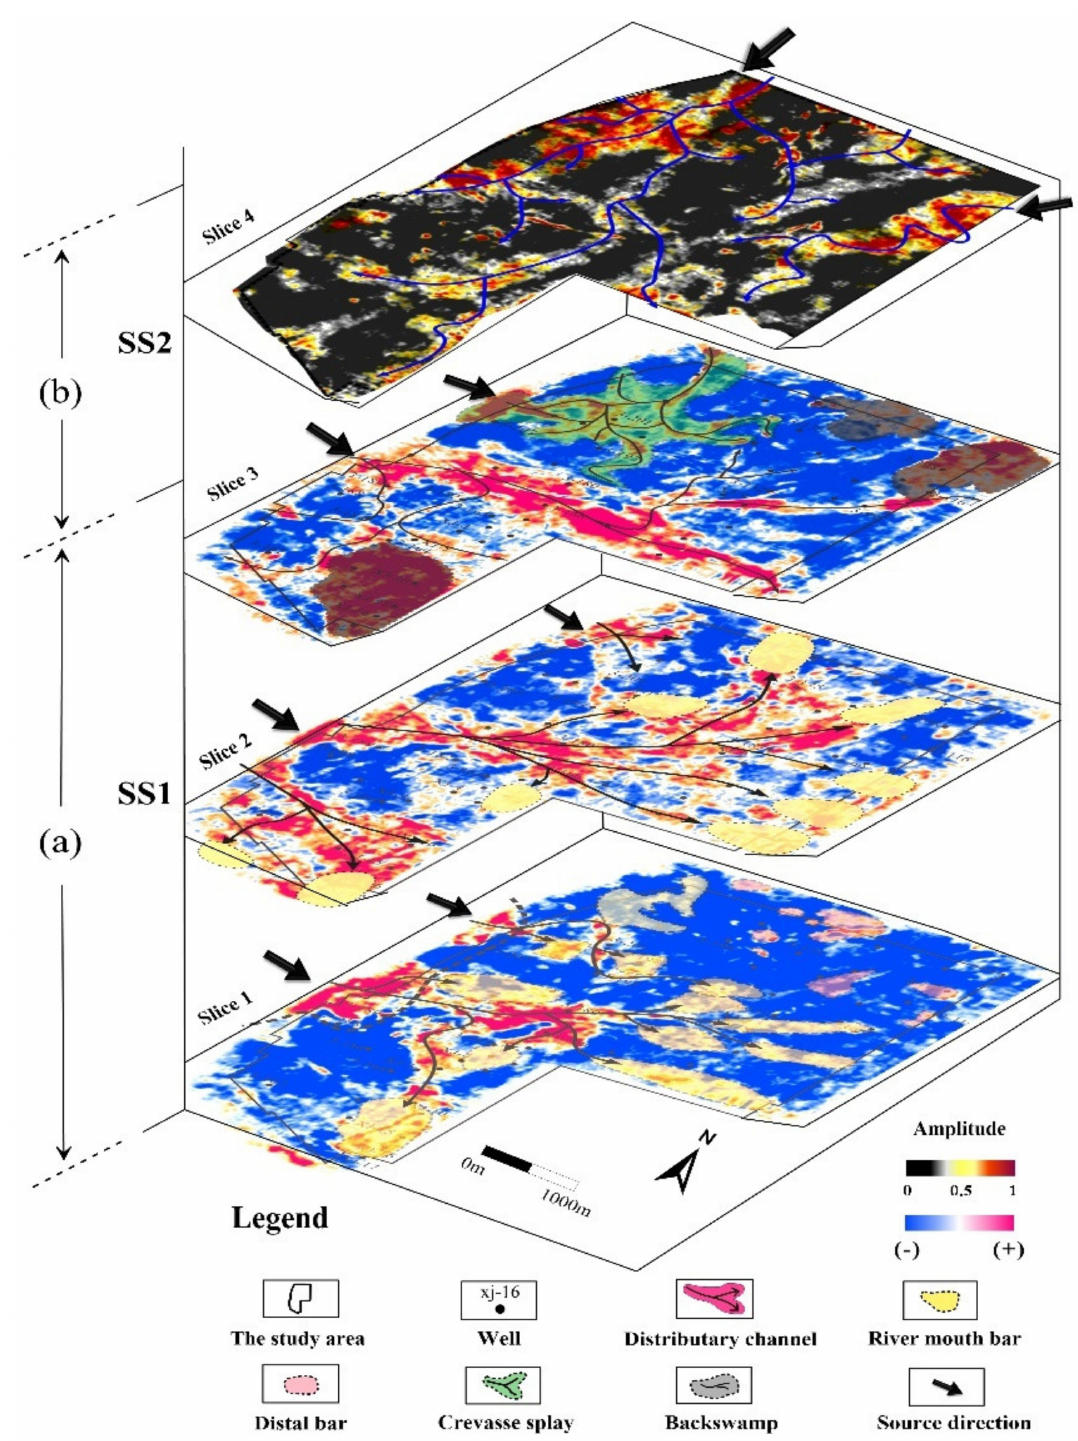
Figure 11. Interpretations of typical stratal slices of the SS1 sequence ( a ) and SS2 sequence ( b ) in the Shanxi Formation. Note that slices 1–3 reflect the sedimentary characteristics of the SS1 sequence and were made on the basis of the phase rotation of the original seismic data. Slice 4 reflects the SS2 sequence, obtained by the frequency–division amplitude fusion